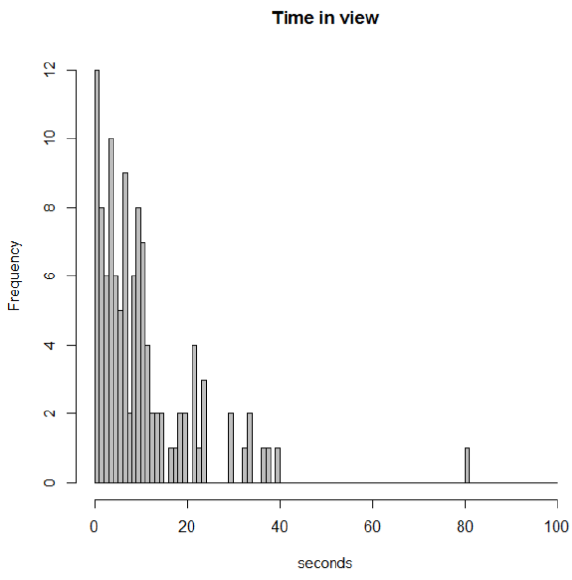
Figure 11. Time in view of 116 unique bowhead sightings with perpendicular distances within 2400 m. Abundance estimates